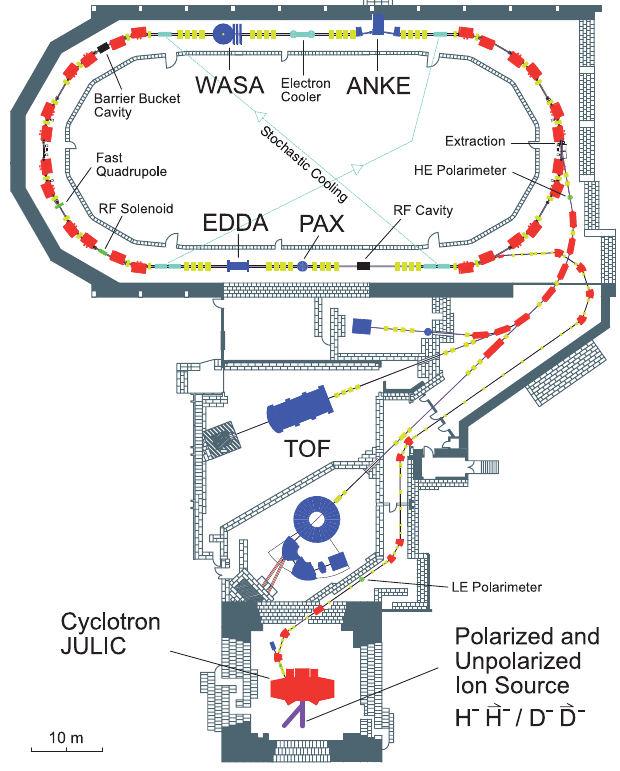
FIG. 1. (Color) The COSY accelerator facility. The cyclotron JULIC provides both unpolarized and polarized proton and deuteron beams for injection into the COSY ring, where they are accelerated and stored. COSY operates in the momentum range of 300 – 3700 MeV =c . The position of the ANKE spec- trometer with the thick internal hydrogen cluster-jet target is shown, as are those of the rf solenoid to depolarize the deuteron beam, the barrier bucket cavity to compensate beam-target energy losses, and the EDDA detector that was used as a beam